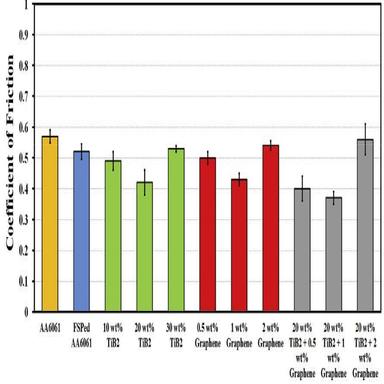
The average coefficient of friction for different compositions of processed materials.